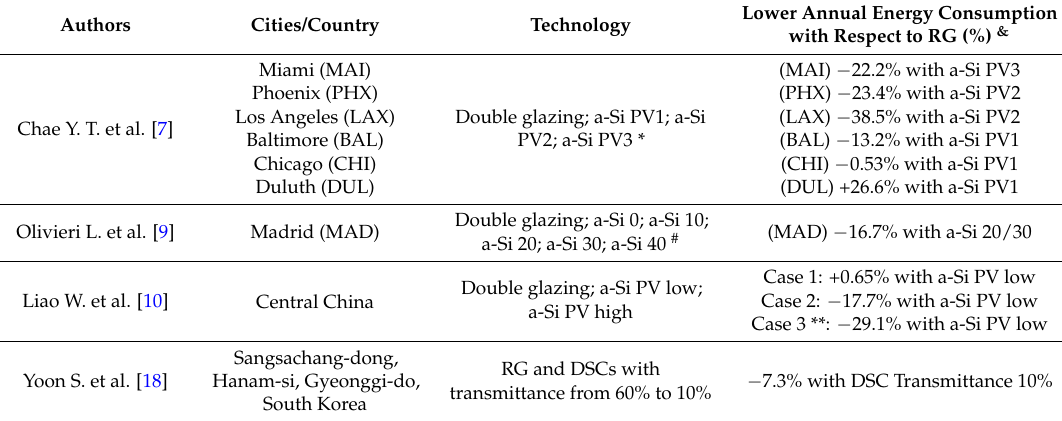
Table 1. List of the major results obtained by various authors in the literature in terms of energy consumption, varying the location and the photovoltaic technology on the